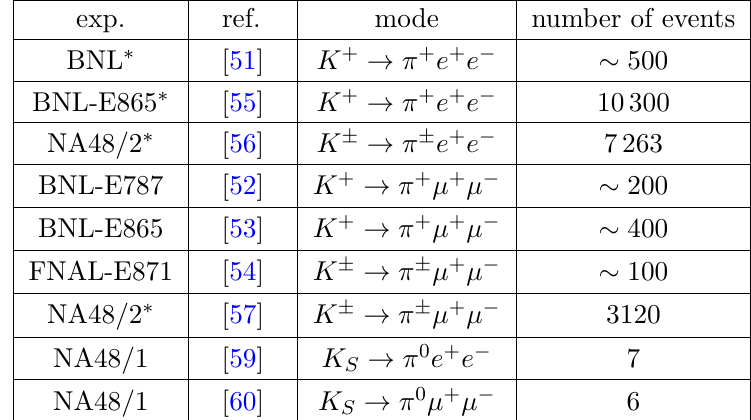
(cid:25) (cid:6) ‘ + ‘ (cid:0) and K S (cid:25) 0 ‘ + ‘ (cid:0) . ! !